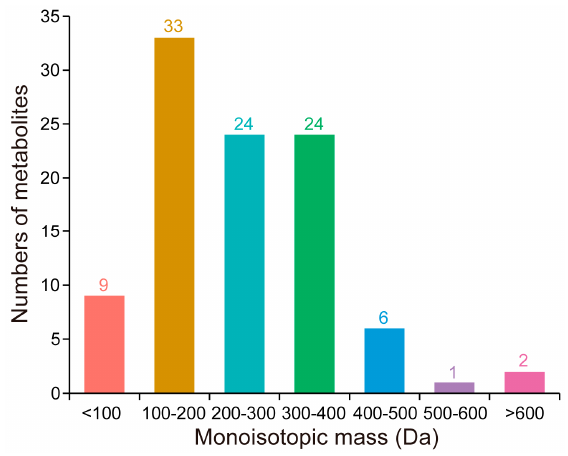
Figure 3. Monoisotopic mass distribution of the identified metabolites.